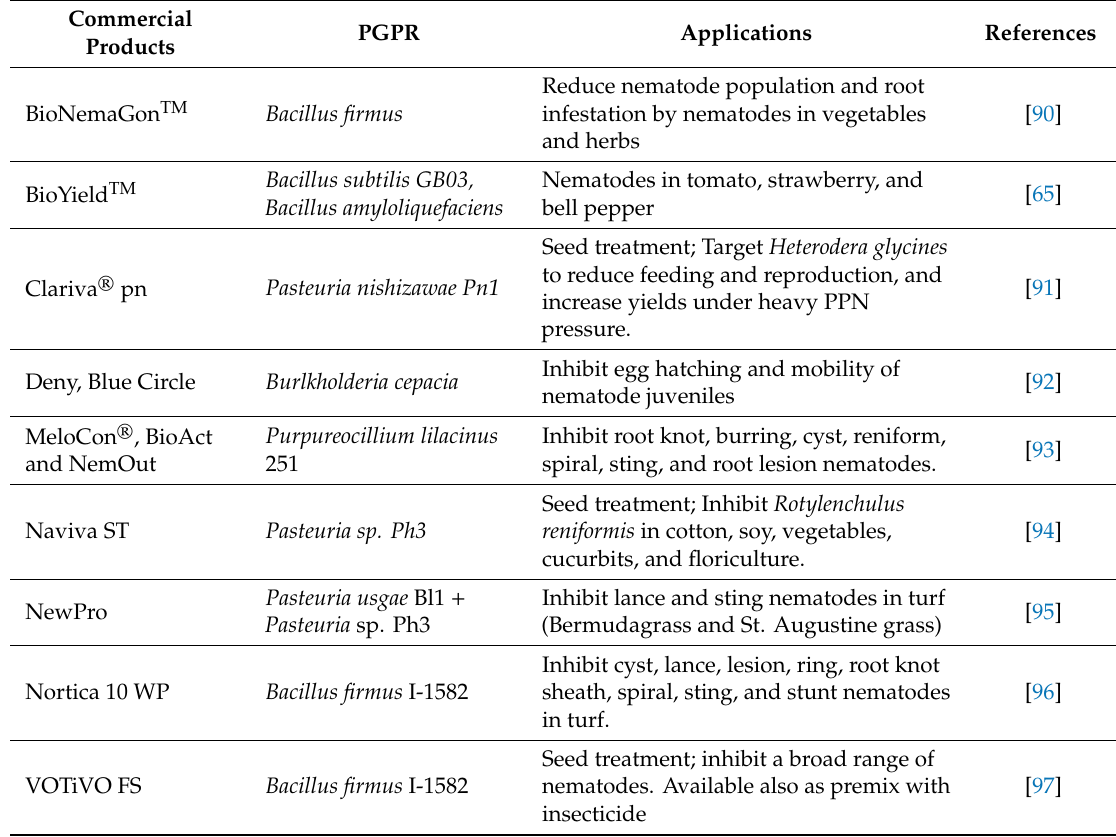
Table 3. A list of PGPR commercialized as BCAs against PPN.